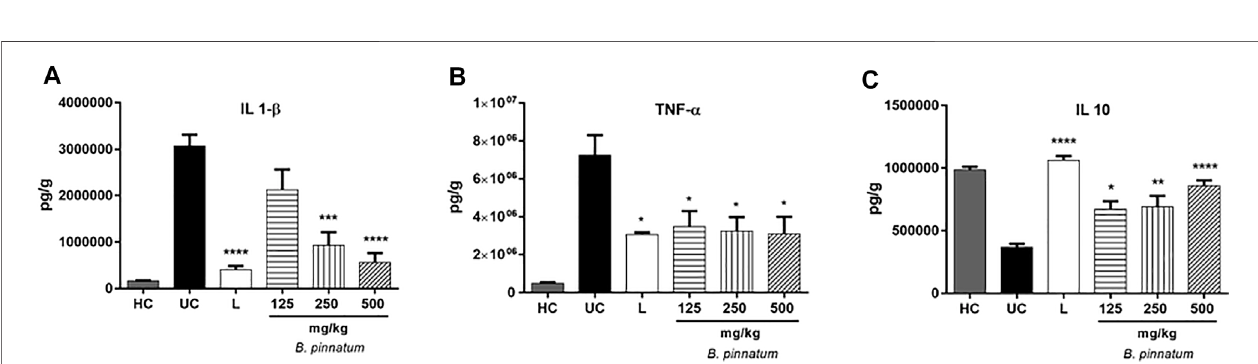
FIGURE7| Effectoftreatmentwith B.pinnatum leafextract(125,250,and500 mg/kg)onIL-1 β ,TNF- α ,andIL-10levelsintheaceticacid – inducedchronicgastric ulcer model in rats. Results expressed as mean ± standard mean error ( n (cid:2) 6). ANOVA and Tukey post-test were used to calculate the statistical signi fi cance, * p < 0.05, ** p < 0.01, *** p < 0.001, **** p < 0.0001 vs. ulcerated control. Healthy control, HC; ulcerated control, UC; lansoprazole (30 mg/kg), L.